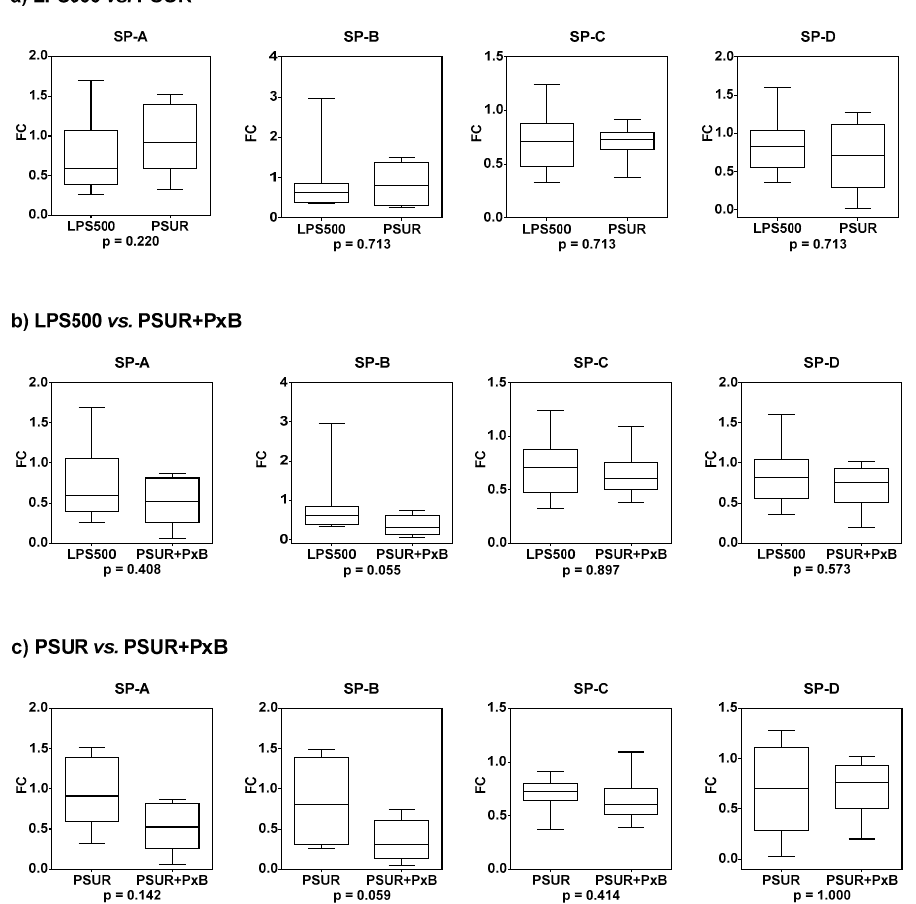
Figure 10. The gene expression of SPs after treatment with ( a ) poractant alfa (PSUR) or ( b ) poractant alfa with polymyxin B (PSUR + PxB) compared to the group treated with LPS 500 µ g / kg. ( c ) Comparison of SP gene expression after treatment with poractant alfa alone or in combination with